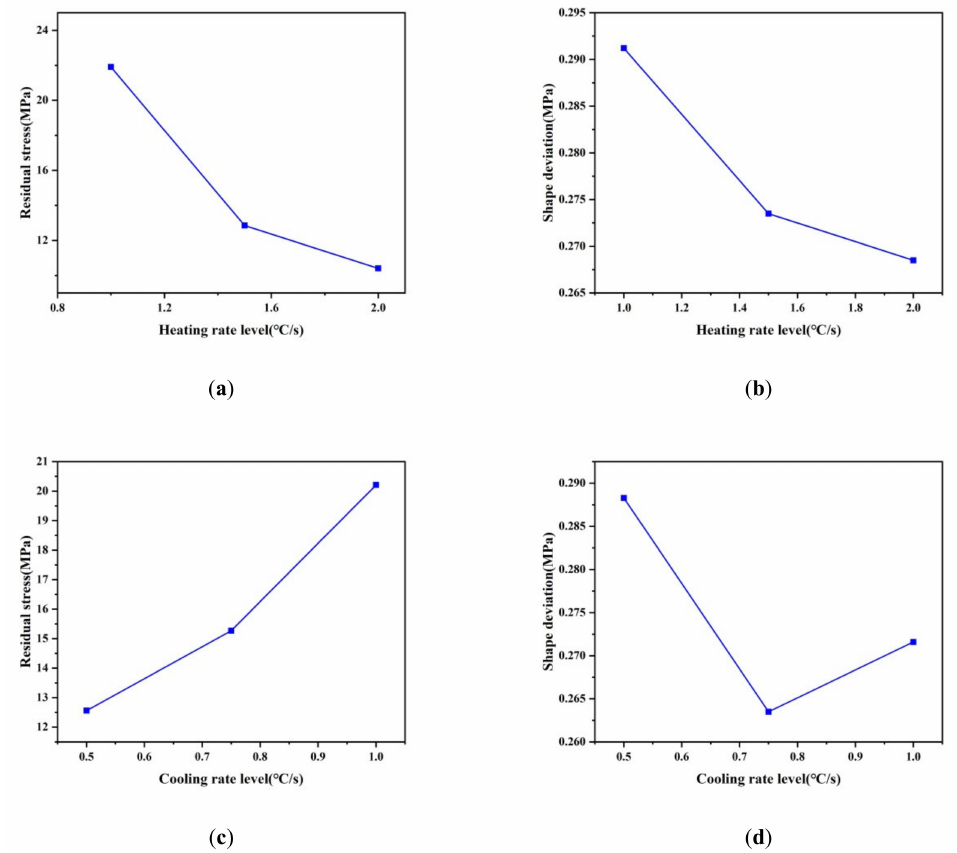
Figure 15. Relationship between process parameters and forming quality; ( a ) Effect of heating rate on residual stress; ( b ) Effect of heating rate on shape deviation; ( c ) Effect of heating rate on residual stress; ( d ) Effect of heating rate on shape